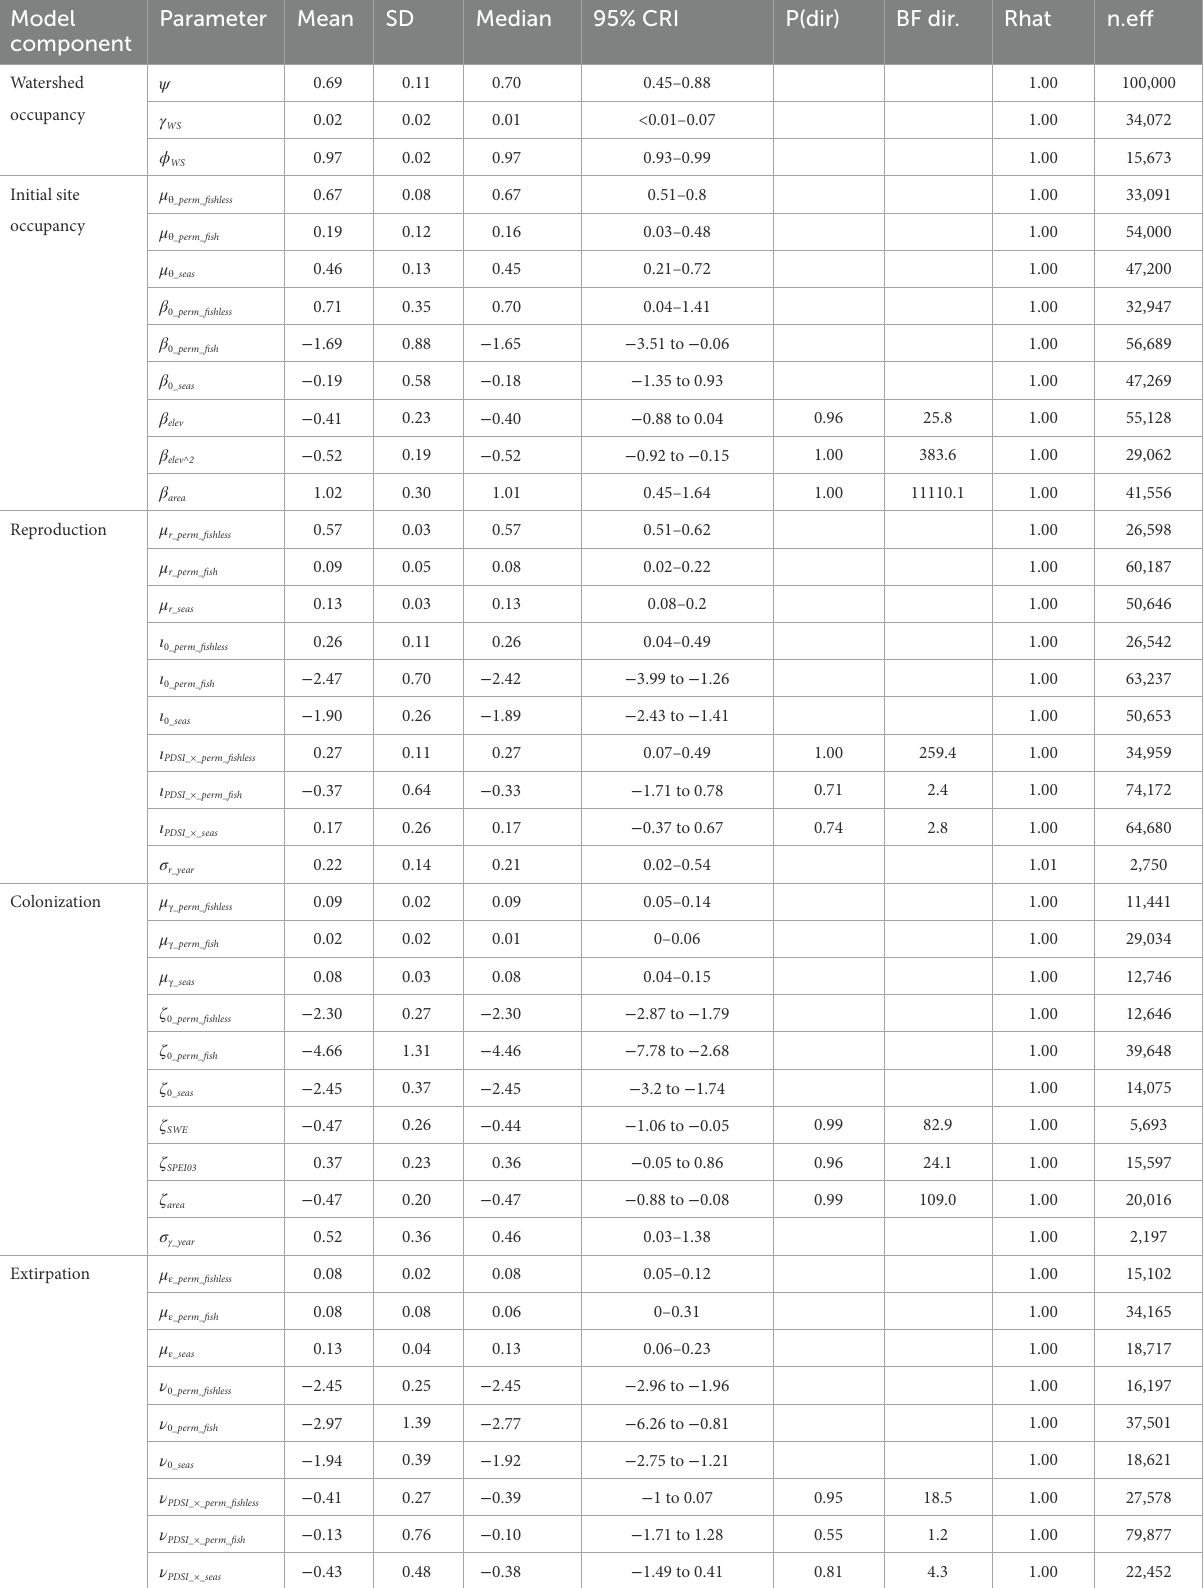
TABLE 3 Posterior summaries and Markov chain Monte Carlo (MCMC) diagnostics of parameters for the multi-state dynamic occupancy model for Sierra Nevada yellow-legged frogs ( Rana sierrae ) in Yosemite National Park, California, United States, 2007–2021. Model Parameter Mean SD Median 95% CRI P(dir) BF dir. Rhat component